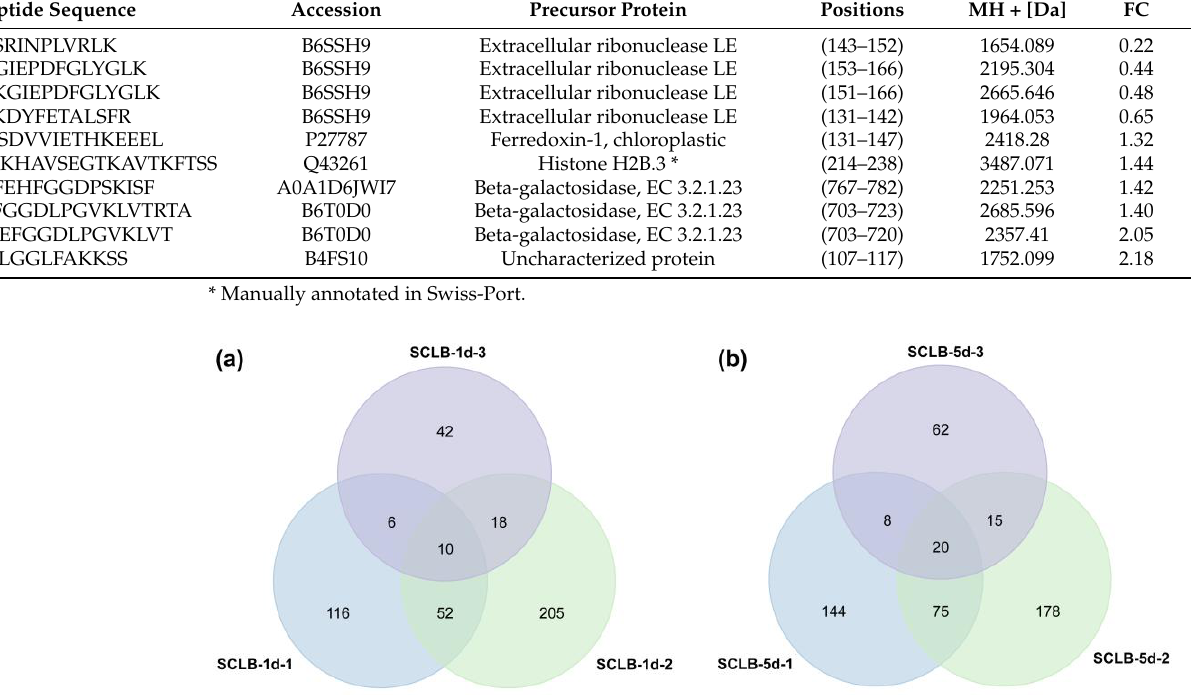
Figure 5. Venn diagrams showing the numbers of differentially expressed peptides (DEPs). ( a ) Overlap of DEPs between SCLB-1d-1, SCLB-1d-2, and SCLB-1d-3. ( b ) Overlap of DEPs between SCLB-5d-1, SCLB-5d-2, and SCLB-5d-3.